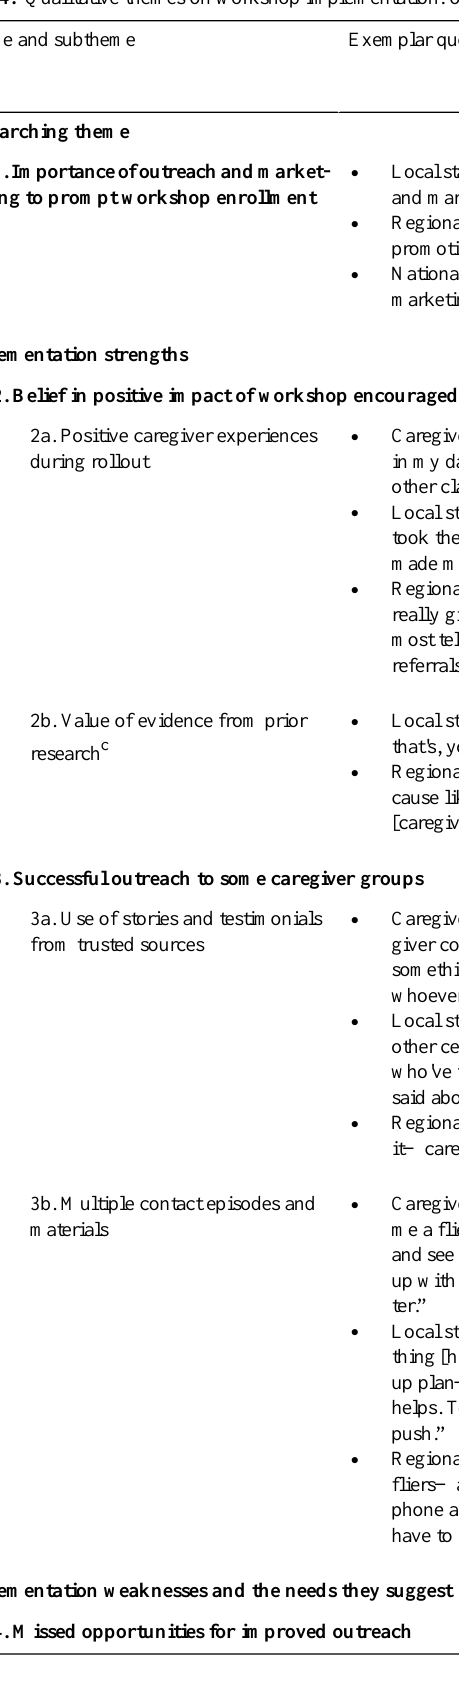
Table 4. Qualitative themes on workshop implementation: overarching theme and themes on strengths and weaknesses.